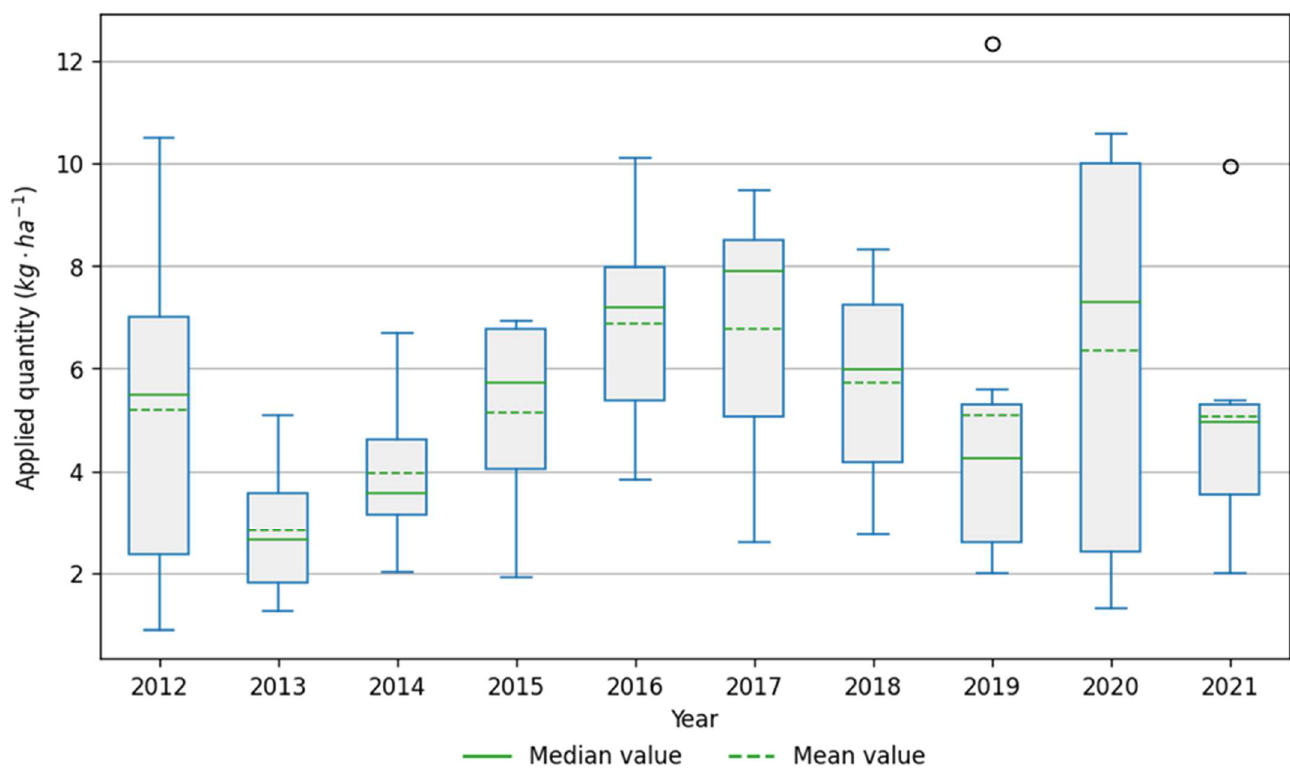
Figure 4. The average Pesticide Load Indicator (PLI) score of individual active substances per hectare per six farms during the 2012–2021 apple-growing seasons.